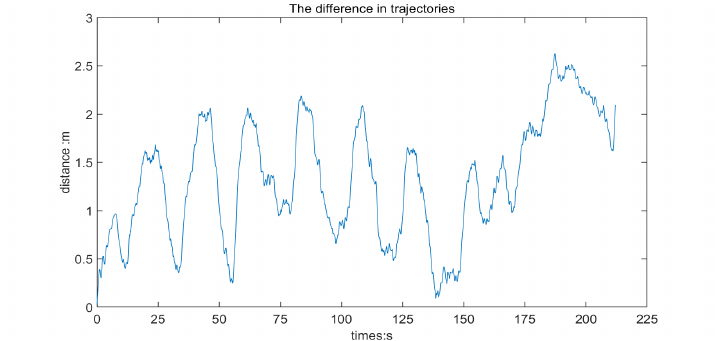
Figure 8. Distance error of coordinate points under simultaneous inscription.